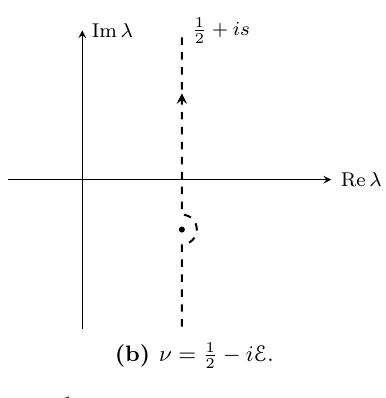
and also encircles the points 2 . 2